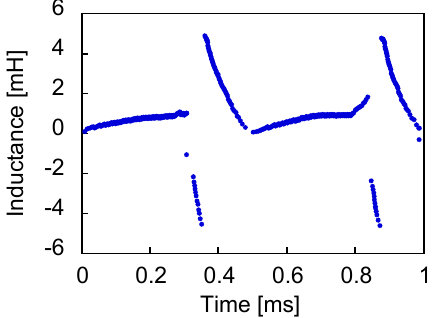
Figure 10. Inductance variability in one cycle from the Φ w - I w loop (1 kHz).